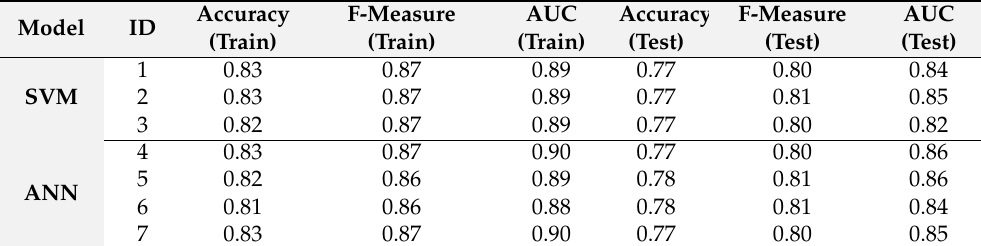
Table 5. Binary classification models results.